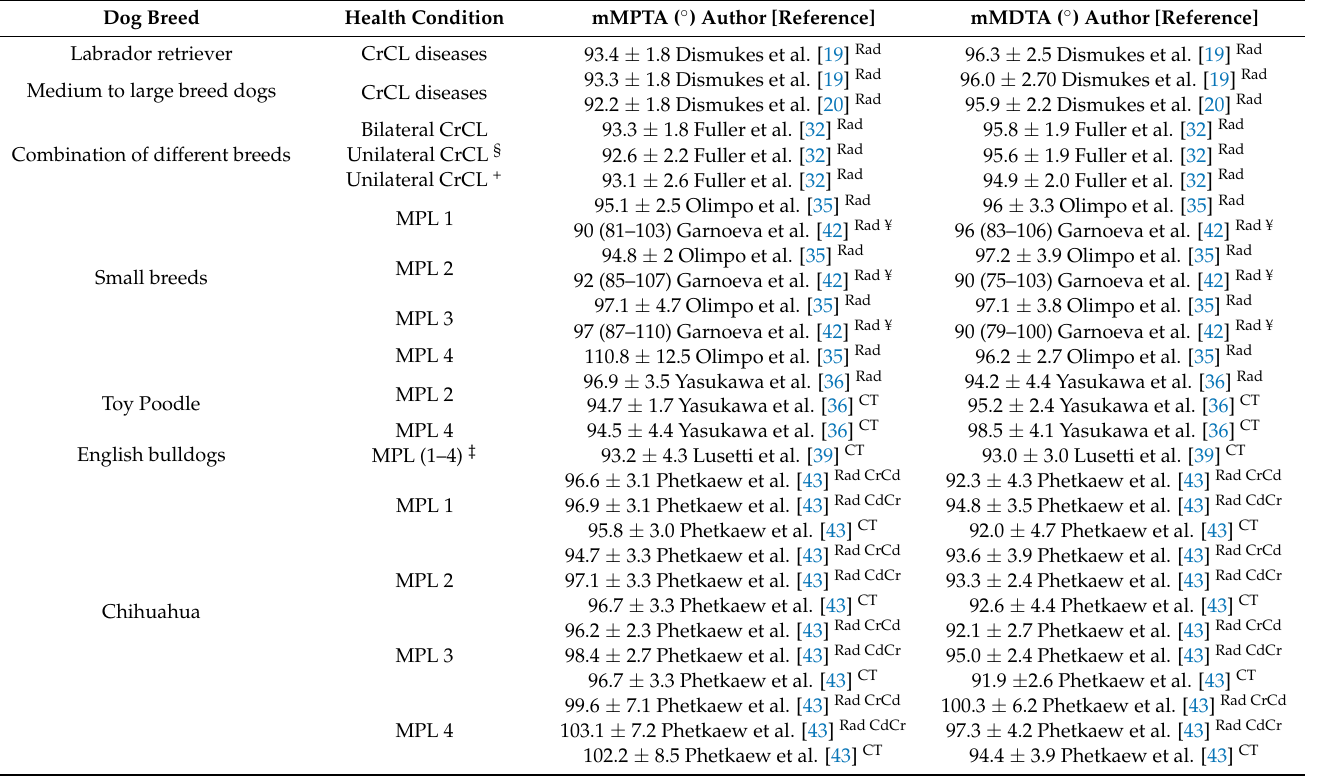
Table 15. Mean ± standard deviation of the mechanical medial proximal tibial angle and mechanical medial distal tibial angle in dogs with MPL and CrCL